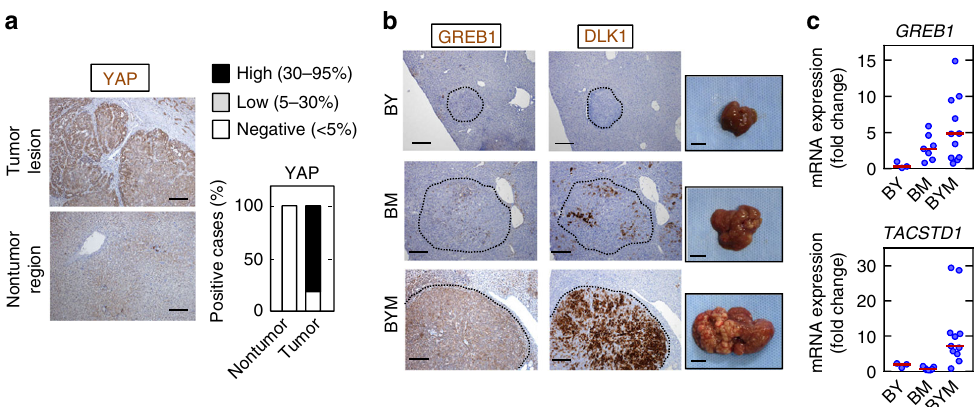
Fig. 6 Forced expression of β -catenin, YAP, and c-Met induced HB-like tumorigenesis in vivo. a HB tissues ( n = 11) were stained with anti-YAP antibody and hematoxylin. Percentages of YAP-positive cases in the tumor lesions and nontumor regions are shown. b Tissue sections of the liver isolated from mice injected with Δ N β -catenin and YAPS127A (BY), Δ N β -catenin and c-Met (BM), or Δ N β -catenin, YAPS127A, and c-Met (BYM) at 6 weeks after hydrodynamic tail vein injection of plasmids, were stained with anti-GREB1, anti-DLK1, and hematoxylin. Solid squares showed the representative gross images of livers from mice injected with BY, BM, or BYM. c Total RNAs were prepared from liver tumor nodules isolated from BY ( n = 3), BM ( n = 7), or BYM ( n = 11) mice. Real-time PCR experiments for GREB1 and TACSTD1 mRNA expression are performed. Results are expressed as fold changes compared with BY and are shown as dots plot with median. Scale bars in a and b (left six panels), 200 μ m; in b (right three panels), 1 cells with clear cytoplasm (Fig. 7g). The expression of N-cadherin,